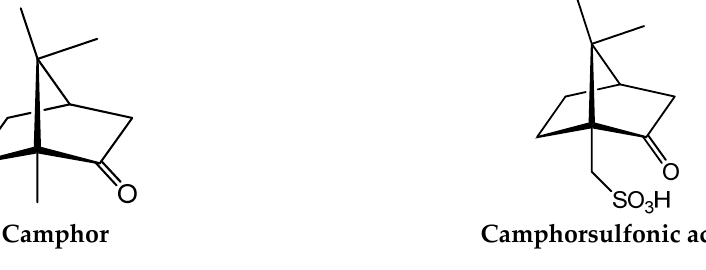
Figure 2. Molecular structures of camphor and camphorsulfonic acid.